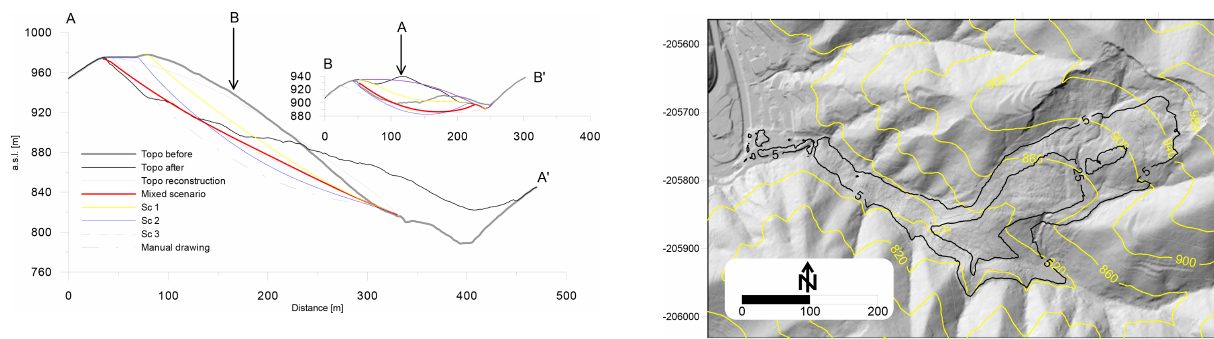
Figure 6. Cross sections of the different scenarios for the Kitamata landslide failure surface and topography reconstructions using the pre-DEM to constrain the altitudes in order to test the method (Sc: scenario). See Fig. 5 for cross section locations.